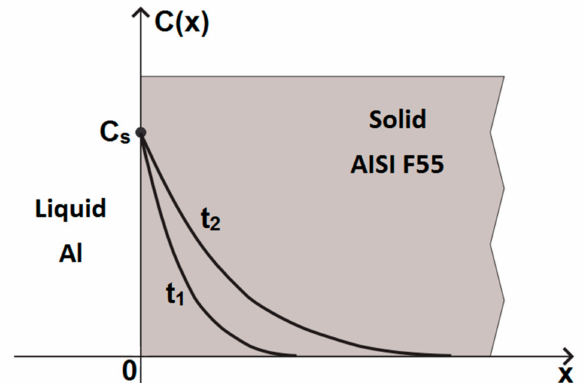
Figure 2. Schematic experimental setup for the hot-dip aluminizing process; the surface of the workpiece is at x = 0 and extends to very large x ; the aluminum concentration profile C ( x ) evolves with time t 2 > t 1 >